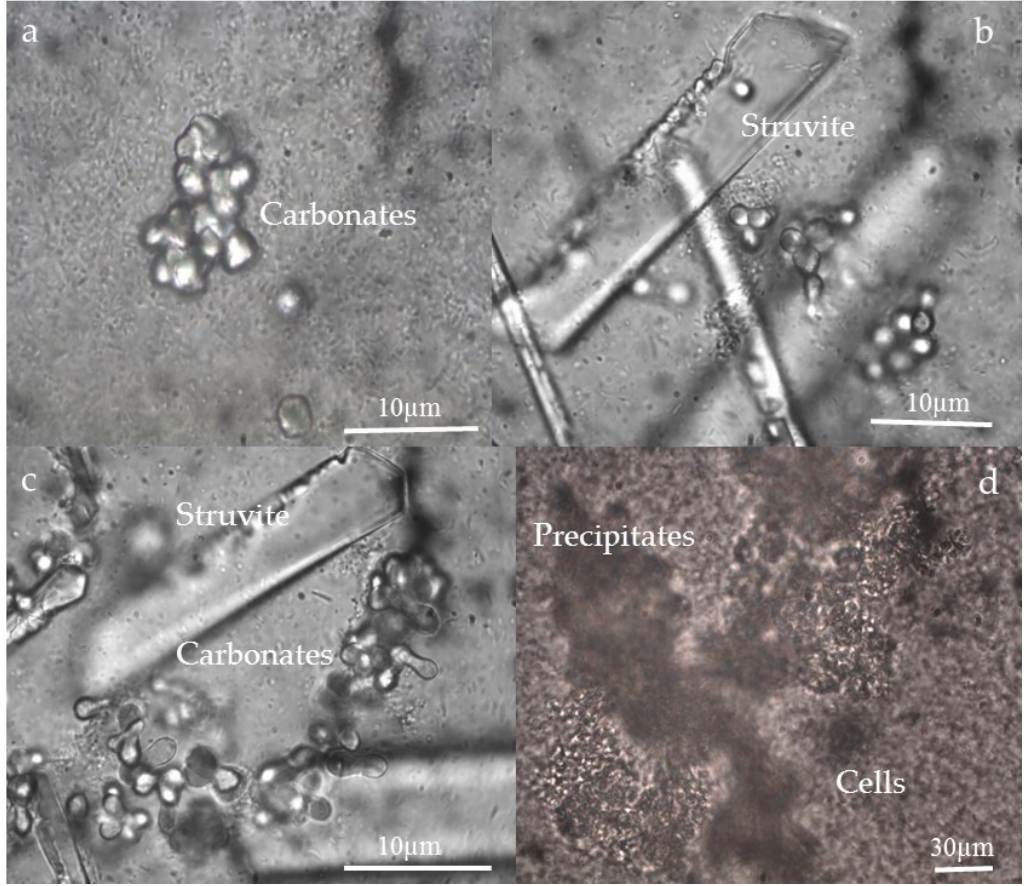
Figure 5. Light microscopic photographs of carbonate and struvite with a mix halophilic culture: ( a , b ) spherical calcite precipitate of different sizes formed (M3 and M6 experiments); ( c ) dumbbell-shaped dolomite precipitates (M6 and M8 experiments); and ( d ) small rounded aggregates around the bacterial colonies.